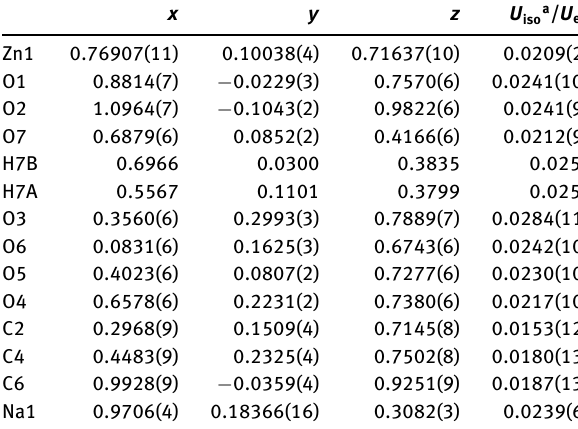
Table 2: Fractional atomic coordinates and isotropic or equivalent isotropic displacement parameters (Å 2